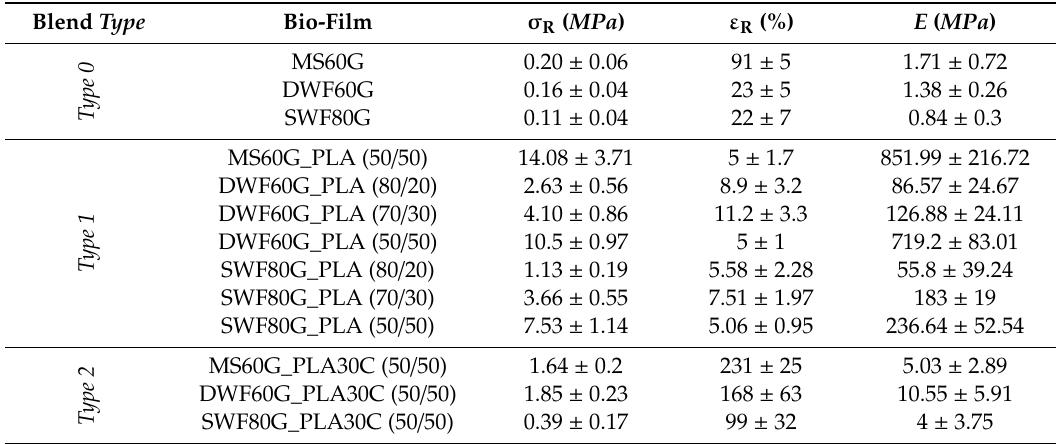
Table 2. Tensile properties of the maize starch (MS)-based, durum waste flour (DWF)-based and soft waste flour (SWF)-based bio-films.